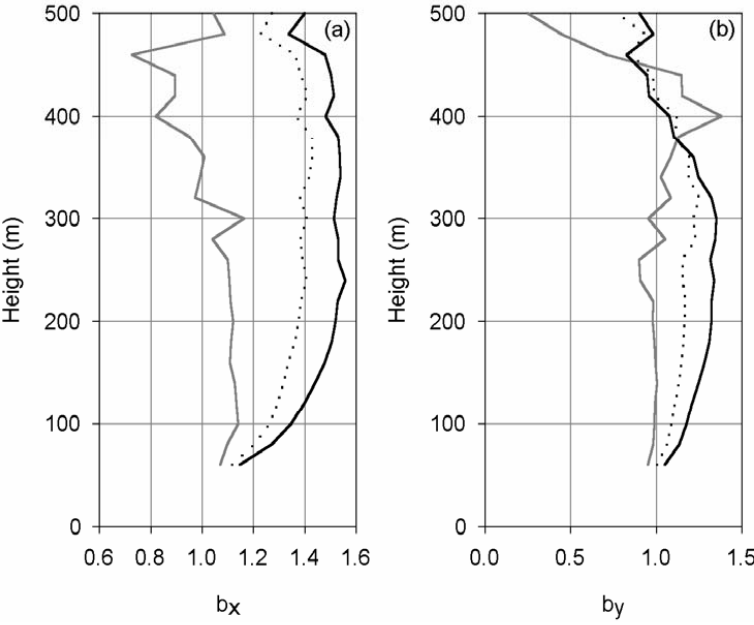
Fig. 11. Parameters calculated for the regression of wind components, dotted line for the global data, in black for the night and in grey for the day.